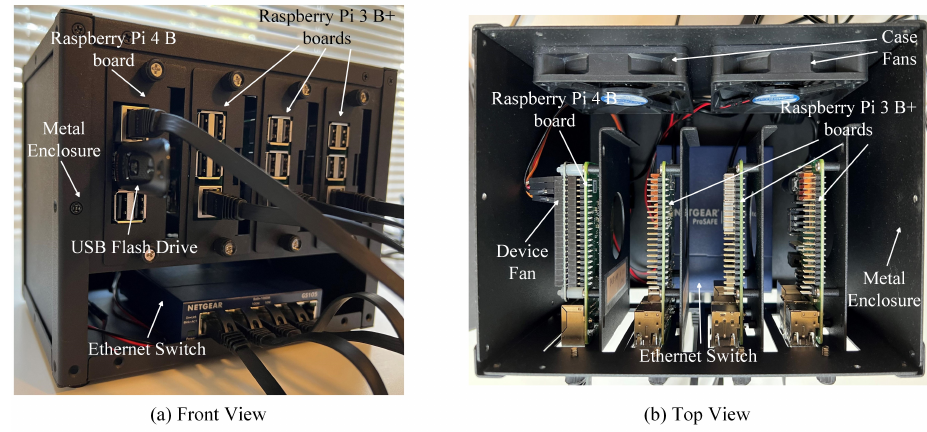
Figure 3. The RPi MicroK8s cluster. ( a ) Front view of the cluster. ( b ) Top view of the cluster.